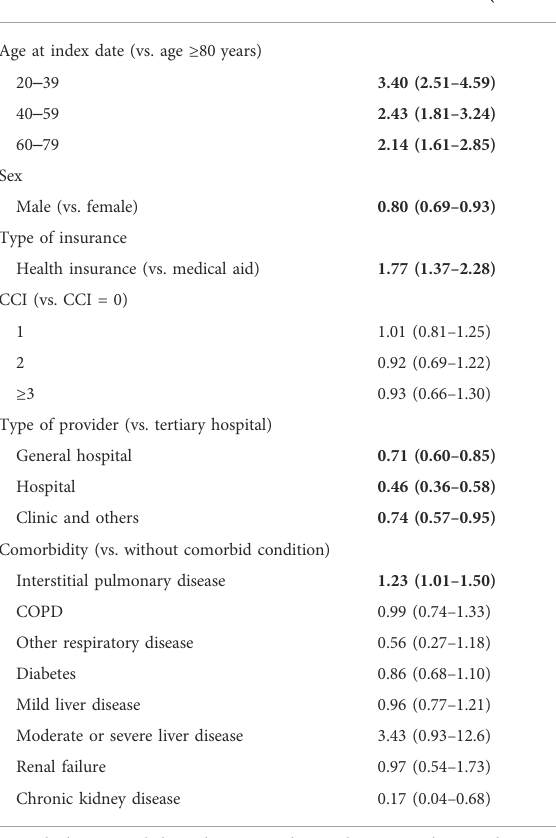
TABLE 2 Factors associated with adherence to initial